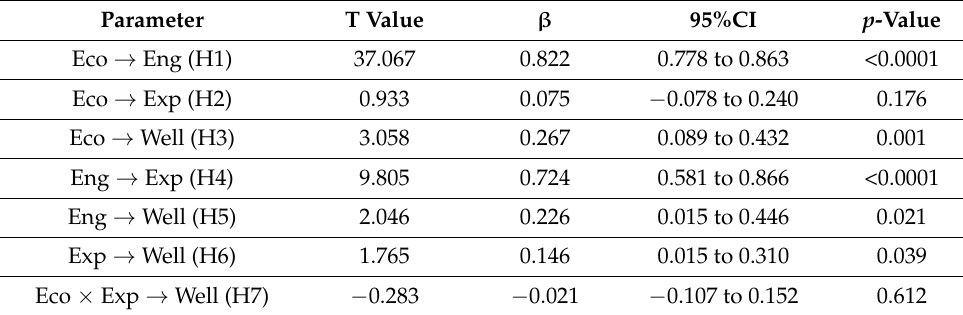
Table 5. Outcomes of the structural